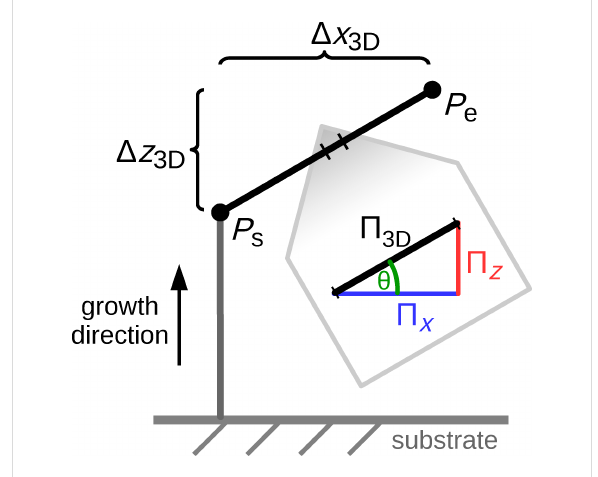
Figure 2: Illustration of the three dimensional pitch Π 3D , projected in the x – z -plane: In every frame each active edge grows in the direction and with the length of Π 3D . The electron beam moves every frame with Π 2D , which is the projection of Π 3D into the x – y -plane. The direction of Π 3D is defined by the start point P s and end point P e . Its length | Π 3D | = s F is determined by several parameters, like x F , z F and the edge’s